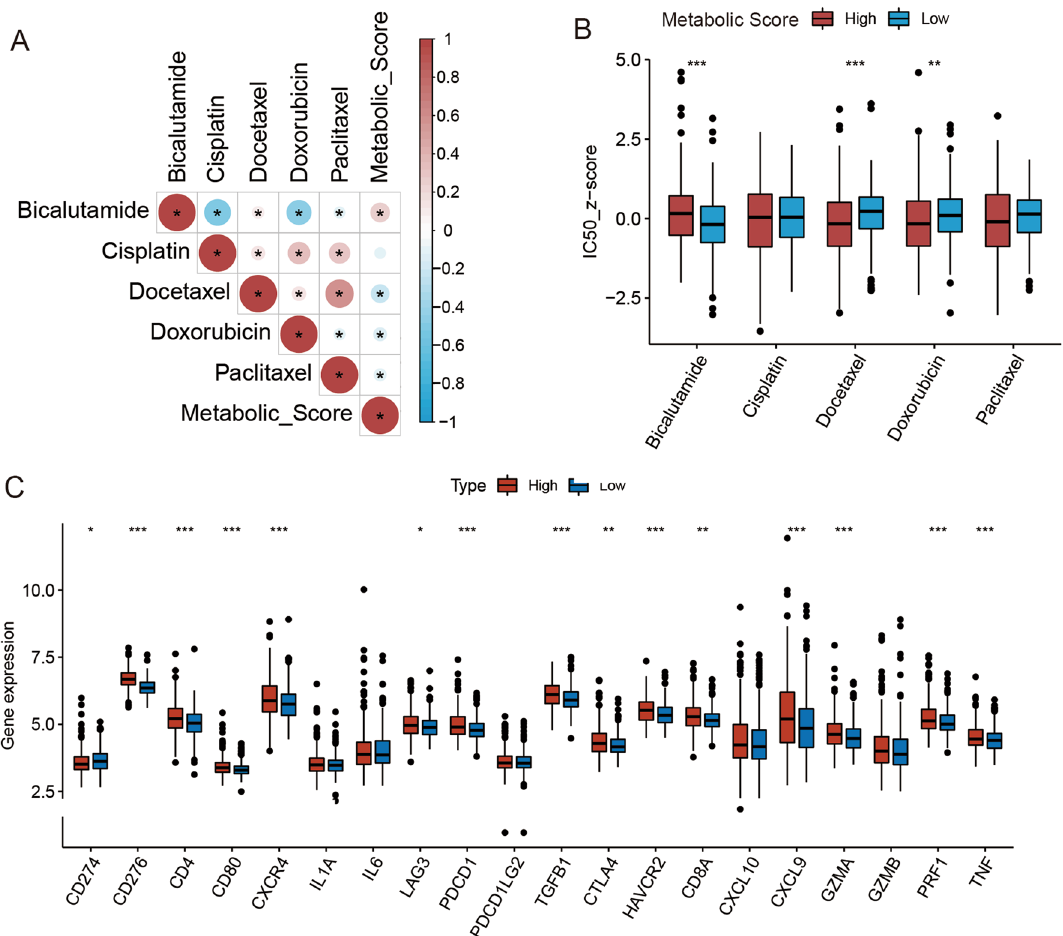
Figure 7. The drug-sensitive analysis. ( A ) The heatmap of the correlation between metabolic score and IC50 of ant-tumor drugs in TCGA cohort. ( B ) Boxplot of IC50 of ant-tumor drugs for low and high metabolic score groups in the TCGA cohort. ( C ) The differences of checkpoints in the high and low metabolism-score subgroups. Wilcoxon test. * p < 0.05; ** p < 0.01; *** p <